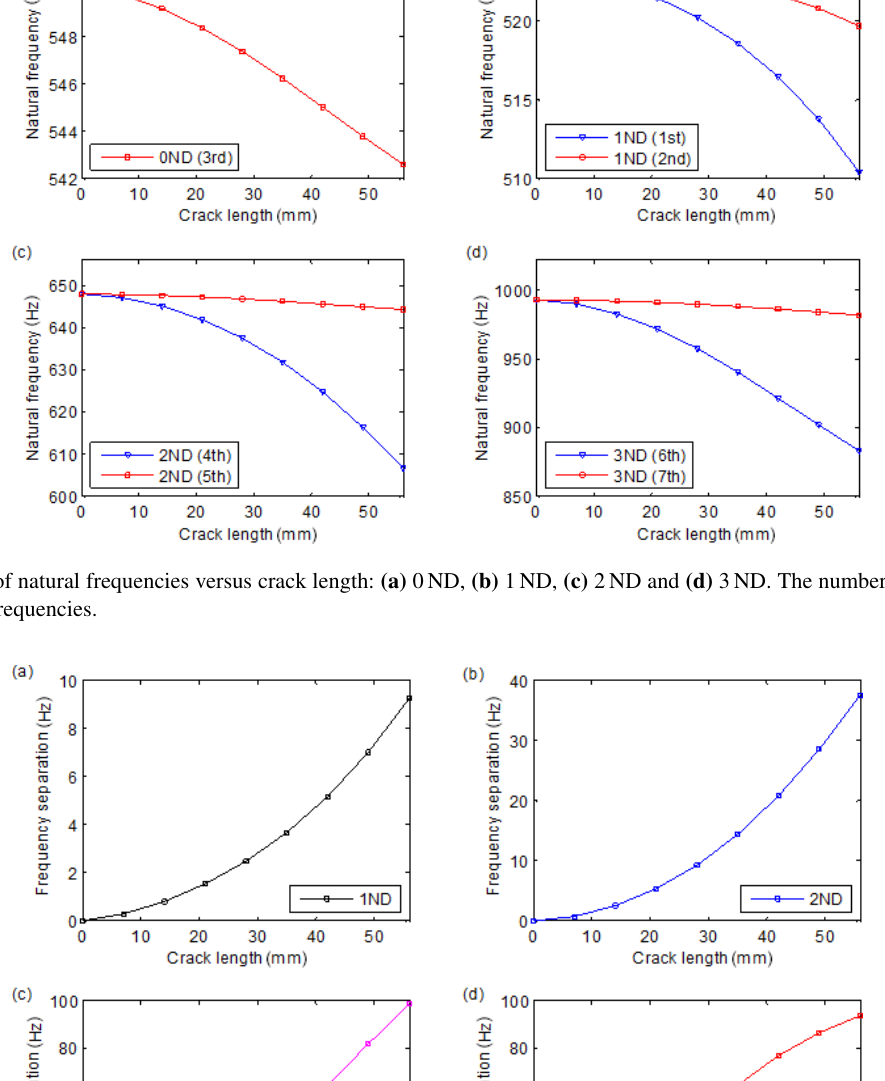
and measuring points are all placed on the impeller.